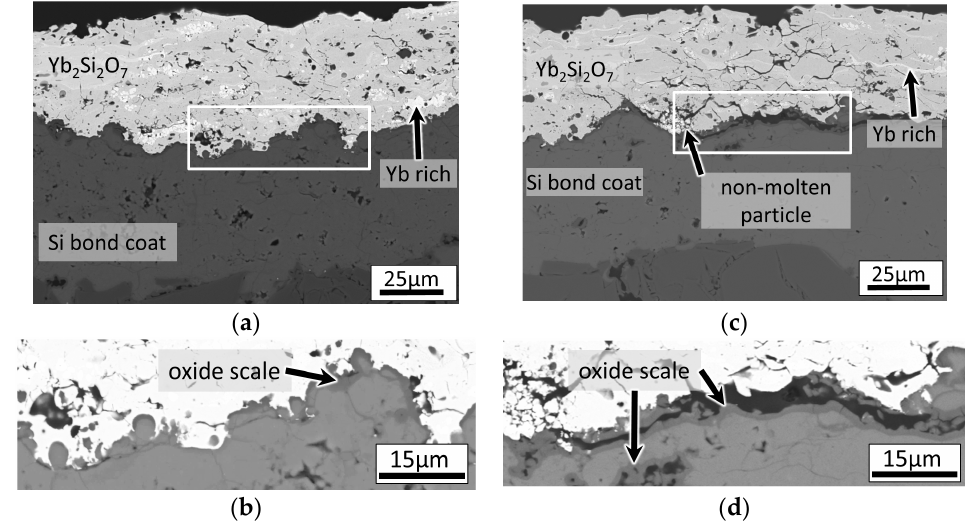
Figure 9. Backscattered SEM micrographs of EBC cross ‐ section after five cycles between 1200 °C and room temperature with 20 h high temperature dwell time. Images ( a , c ) are taken from the different regions of the same sample. White rectangles in ( a,c ) indicate the region of high ‐ magnification images shown below ( b , d ), in which oxidation of the silicon coating at the Si/Yb 2 Si 2 O 7 interface as well as on the pore surfaces is clearly visible via darker image contrast.